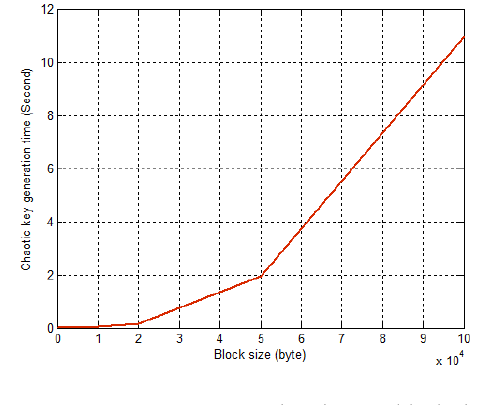
Fig. 16. Key 1 generation time vs. block size Fig. 17. Key 2 generation time vs. block size